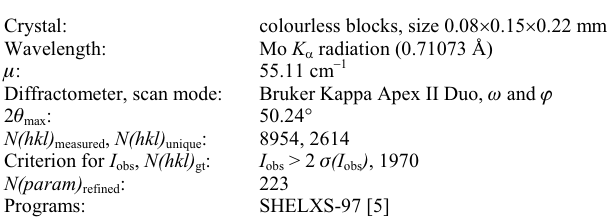
Table 1. Data collection and handling.